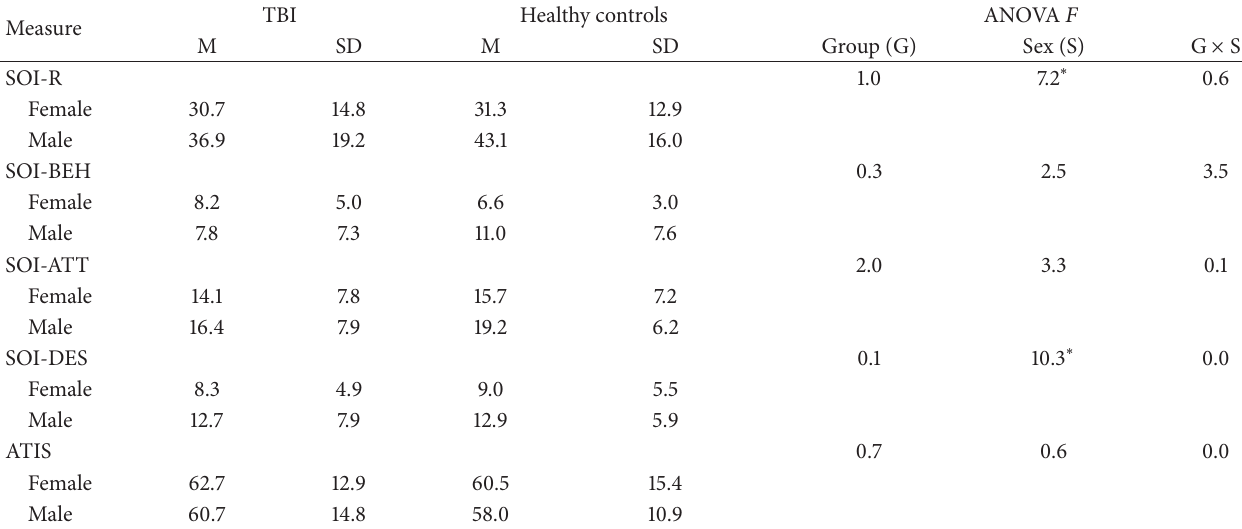
Table 3: Means, standard deviations, and analysis of variance (ANOVA) results for sociosexuality and infidelity as a function of group and sex.